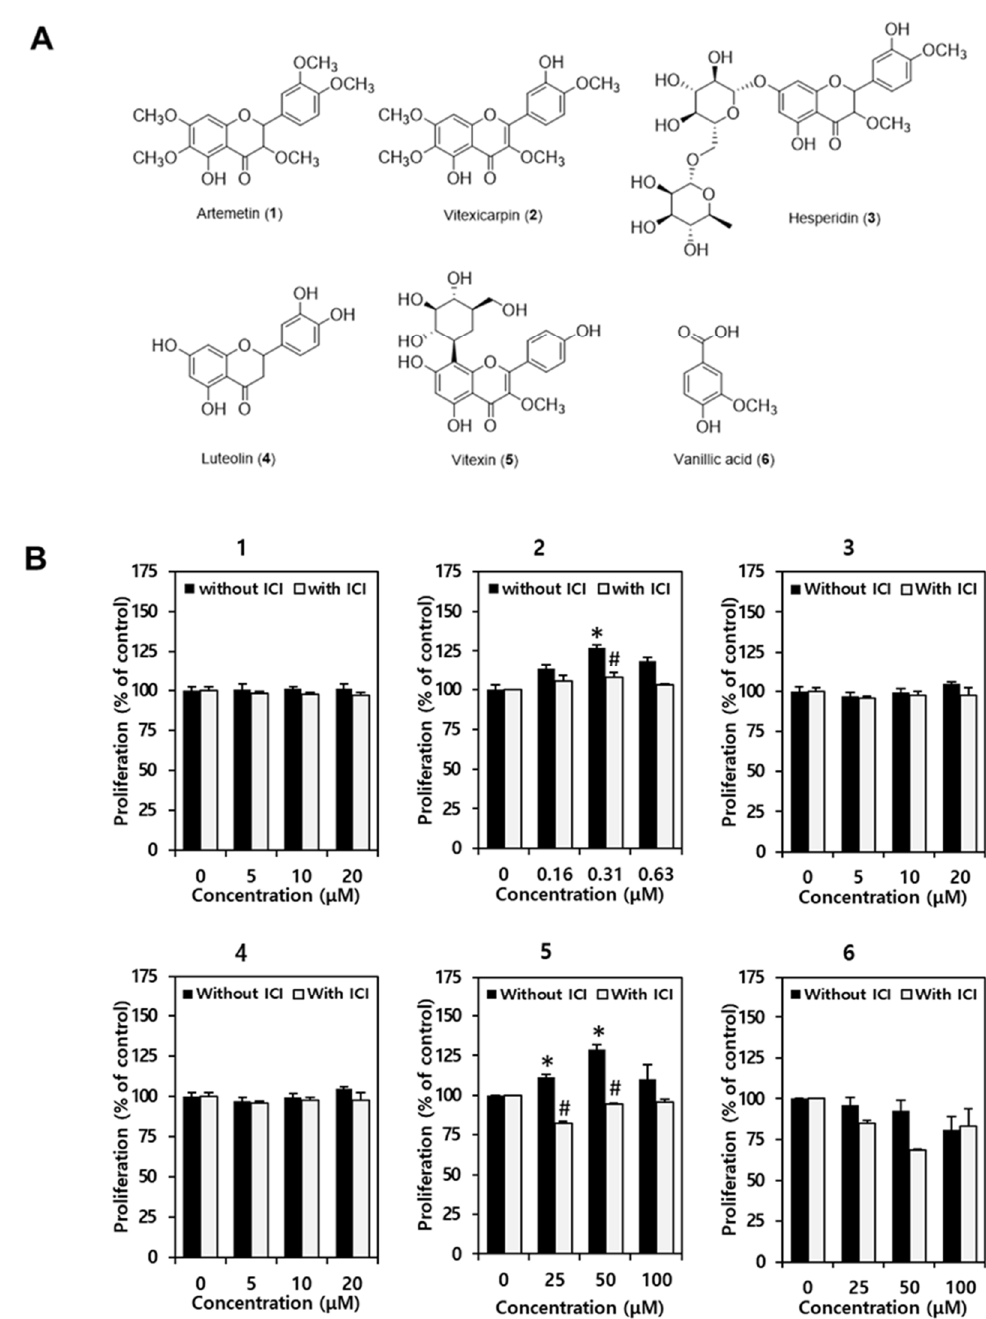
Figure 3. Structures of compounds 1 – 6 isolated from the fruits of V. rotundifolia . Artemetin ( 1 ), vitexicarpin ( 2 ), hesperidin ( 3 ), luteolin ( 4 ), vitexin ( 5 ), and vanillic acid ( 6 ) ( A ). The estrogenic effects of the constituents from V. rotundifolia fruits on MCF-7 cell proliferation ( B ). The data are represented as the mean ± standard error mean (SEM). Statistical significance was evaluated and determined by a one-way analysis of variance (ANOVA), followed by the Tukey’s post-hoc test. Differences between means were considered statistically significant when p < 0.05. * p < 0.05 vs. untreated cells. # p < 0.05 vs. each group without ICI 182,780 treatment. ICI: ICI 182,780.